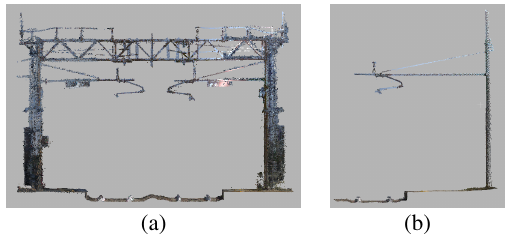
Figure 2. Examples of objects to be classified (rails are included in order to ease the readability of the figures on the top).